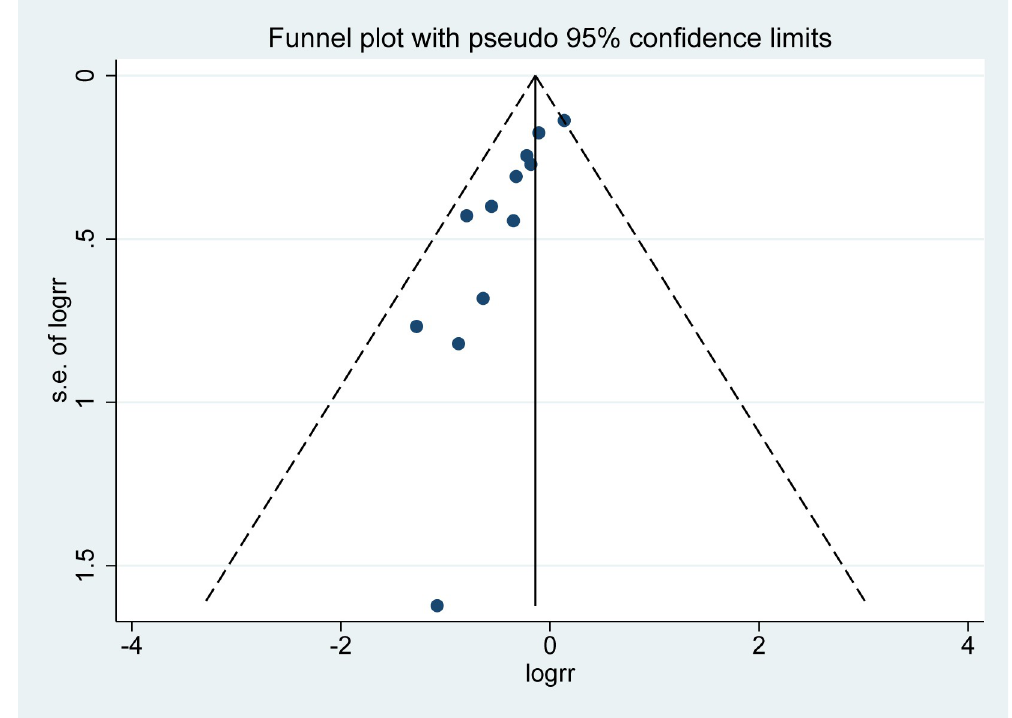
Fig 2. The funnel plot of studies included in cesarean section